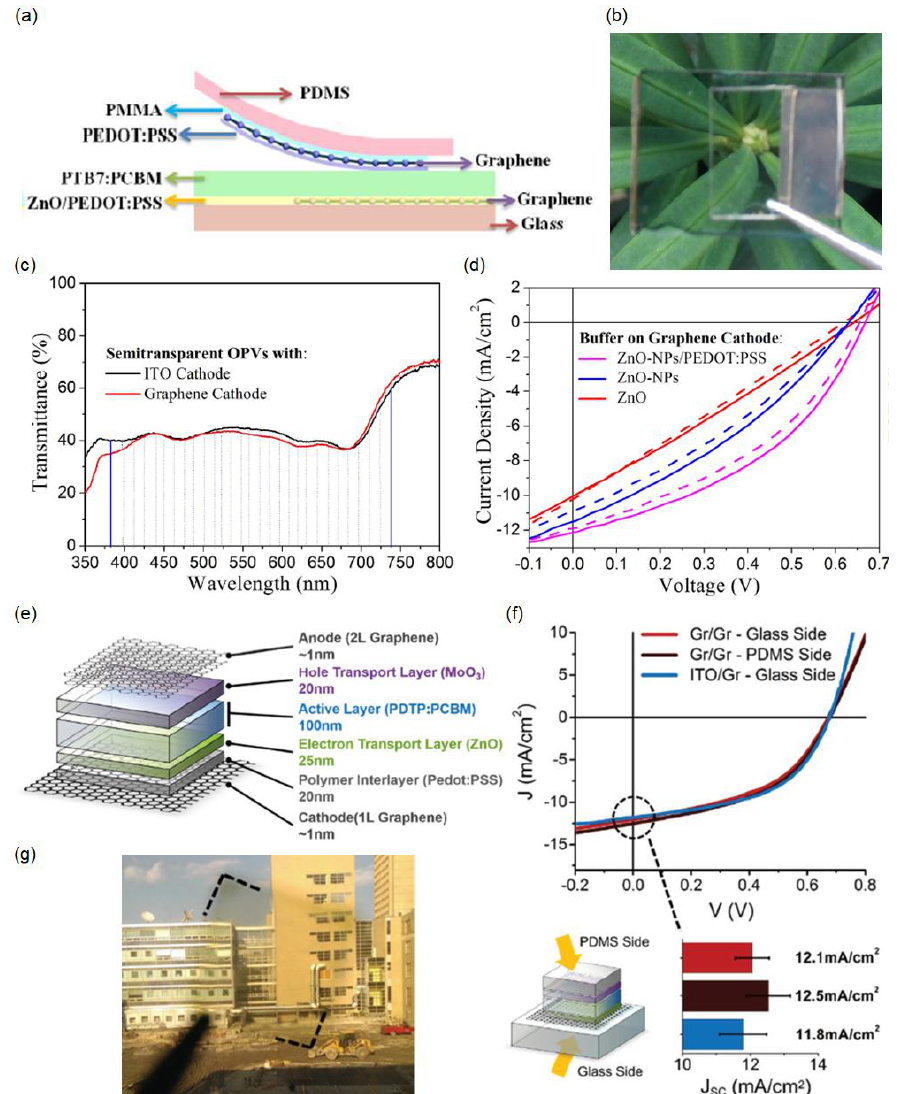
Figure 5. ( a ) Schematic illustration of the semitransparent organic solar cell with all-graphene electrodes; ( b ) Neutral-colored SSC with all-graphene electrodes; ( c ) Transmission profiles of two semitransparent organic solar cells with graphene anodes and graphene or ITO cathodes. The dashed lines indicate the visible region; ( d ) J – V characteristics of the SSC with all-graphene electrodes. The graphene cathodes were modified with different buffer layers. The devices were illuminated and characterized from the anode (solid line) and cathode (dash line). Reproduced with permission [98]. Copyright 2015, American Chemical Society; ( e ) Device structure with approximate layer thicknesses; ( f ) J – V curves of the PC 70 BM graphene/graphene devices illuminated from the glass (cathode) side versus the polydimethylsiloxane (PDMS) (anode) side. The J – V curve of a PC 70 BM ITO/graphene device illuminated from the glass/ITO side is included for reference. The lower-right bar chart shows the average J sc values for these configurations; ( g ) Photograph taken through a PC 60 BM device. The dotted lines outline the corners of the device. Reproduced with permission [99]. Copyright 2015, Wiley. PMMA: Poly(methyl methacrylate).